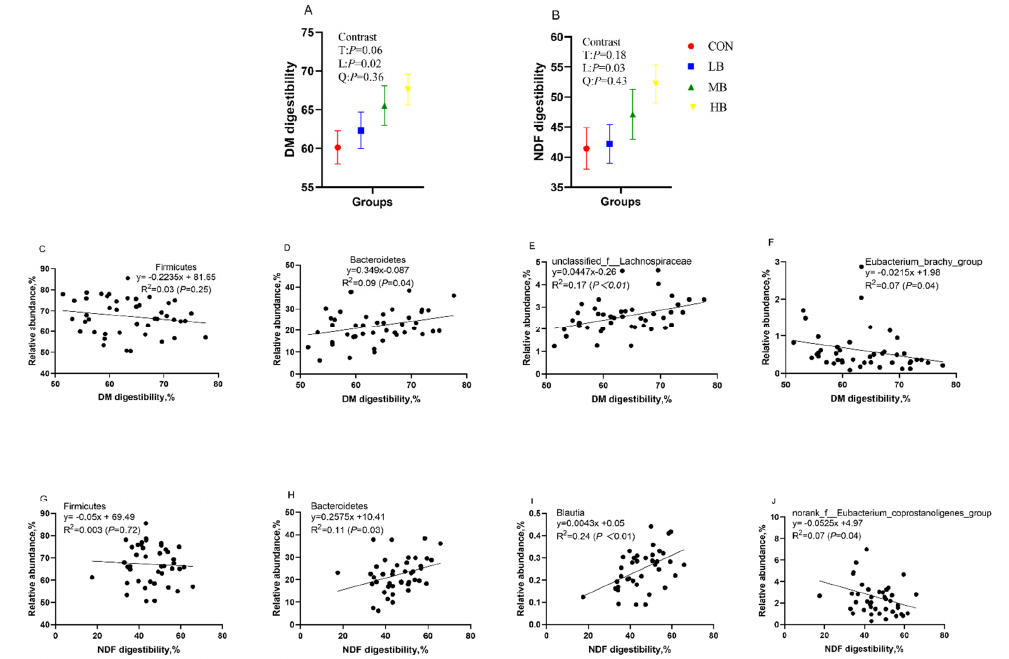
Figure 5. The DM ( A ) and NDF ( B ) digestibility of cows fed treatment diets, the correlation be- tween DM digestibility and the relative abundance of Firmicutes ( C ) and Bacteroidetes ( D ) at the phylum level, and the relative abundance of unclassified_f__Lachnospiraceae ( E ) and Eubacte- rium_brachy_group ( F ) at the genera level; and the correlation between NDF digestibility and the relative abundance of Firmicutes ( G ) and Bacteroidetes ( H ) at the phylum level and the relative abundance of Blautia ( I ) and norank_f__Eubacterium_coprostanoligenes_group ( J ) at the genera level. CON (control, no by-products), low by-products (1.67%) (LB: 0.83% SH + 0.84% BP), medium by-products (3.33%) (MB: 1.67% SH + 1.66% BP), and high by-products (5%) (HB: 2.5% SH + 2.5%